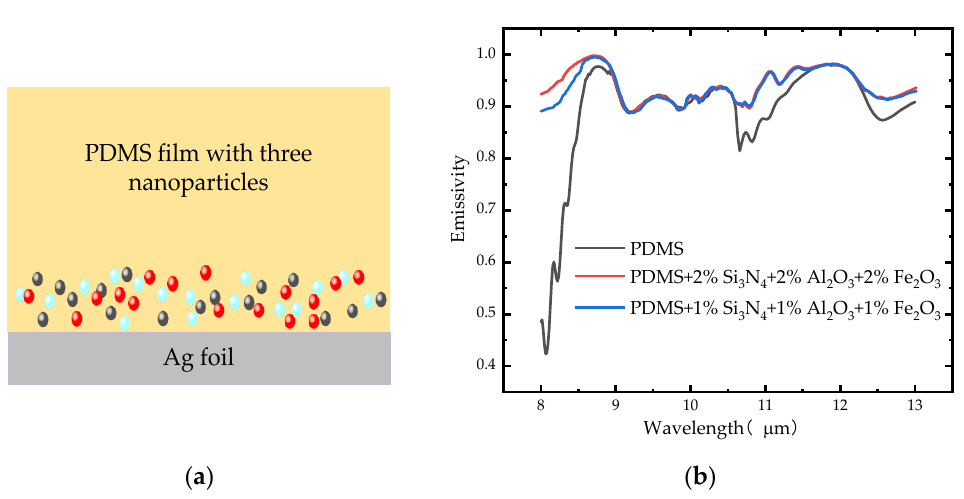
Figure 8. Mixed particles of different proportions were added to PDMS films. ( a ) Schematic diagram of PDMS material with three particles added on Ag foil base; ( b ) influence of different proportions of mixed particles on emissivity.